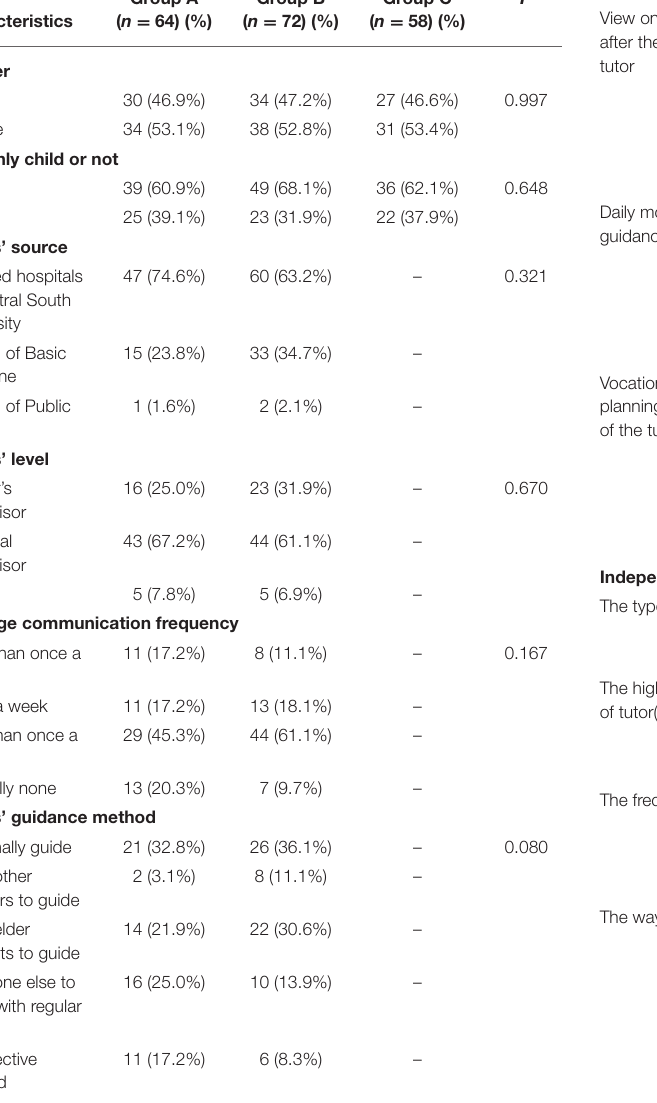
TABLE 1 | Demographic characteristics and basic information of the involved students and their tutors. Basic characteristics